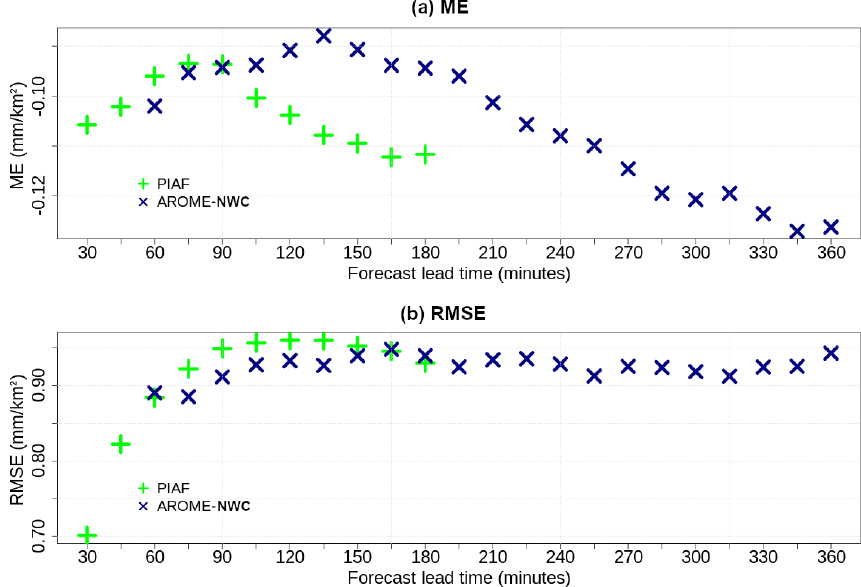
Figure 4. (a) Mean and (b) root mean square errors for AROME-NWC (in blue) and PIAF (in green) over their respective forecast ranges for 15min rain accumulation forecasts. Scores computed over the box displayed in Fig.